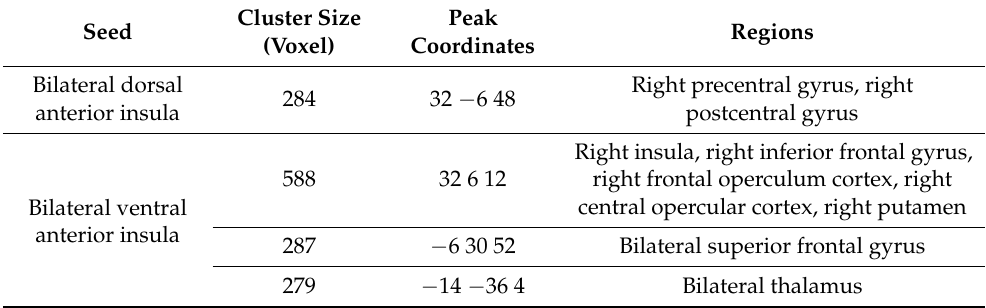
Table 1. Insula seed functional connectivity clusters associated with musical